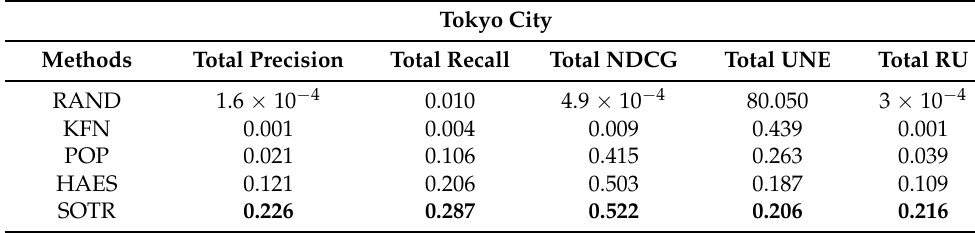
Table 3. Represents the experimental results for Tokyo City.